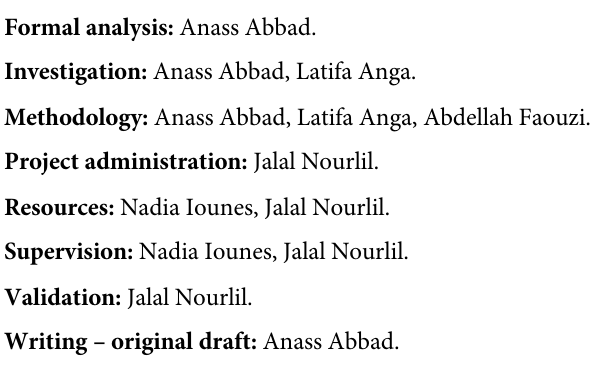
molecular dynamics simulation period. (c) Solvent accessible surface area (SASA) of the human DPP4 protein during 150 ns of the molecular dynamics simulation period. (d) Solvent accessible surface area (SASA) of the MERS-CoV S1 RBD protein during 150 ns of the molecu- lar dynamics simulation period. S4 Fig. Snapshots of wild type and mutant 4L72 models conformation at each 50 ns simula- tion time step during MD simulation. DPP4 and MERS-CoV S protein are dyed respectively with grey and blue. Local structural changes during MD simulation in DPP4 blade IV and V were highlighted in a red square, while local structural changes during MD simulation in MERS-CoV S1 RBD were highlighted in a red circle. S1 Table. DPP4 structure model validation values using ProSA and Verify 3D web server. S2 Table. Docking validation values of DPP4 –MERS-CoV S1 RBD complex structure model using HADDOCK 2.4 webserver. S3 Table. Summary of DPP4 –MERS-CoV S1 RBD complex structure validation parame- ters in prior molecular dynamics simulation production. S4 Table. Molecular dynamics analysis parameters (RMSD, RMSF, Rg, SASA and H-bond) mean values and standard deviation for each complex model and individual component,